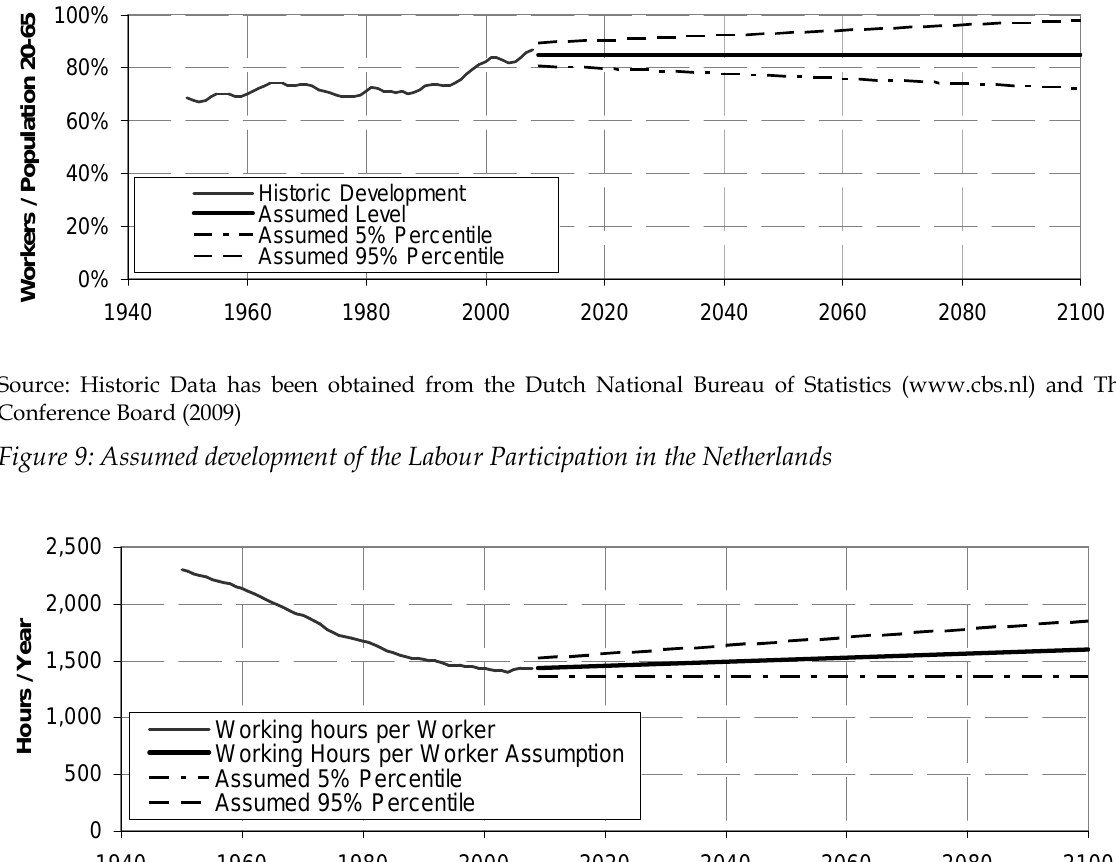
Figure 10: Assumed development of Annual Working Hours per